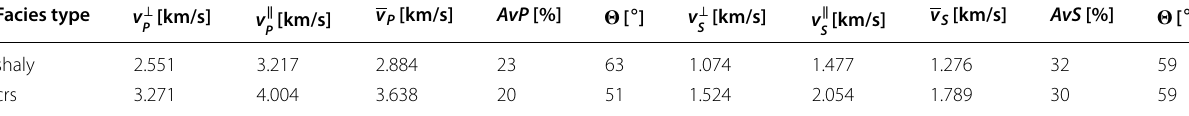
Velocities and angle were estimated by fitting an ellipse to the P- and S-wave data (Fig. 4), whereas the seismic velocity anisotropies AvP and AvS were determined according to Eq. (1). The orientation is related to the bedding strike